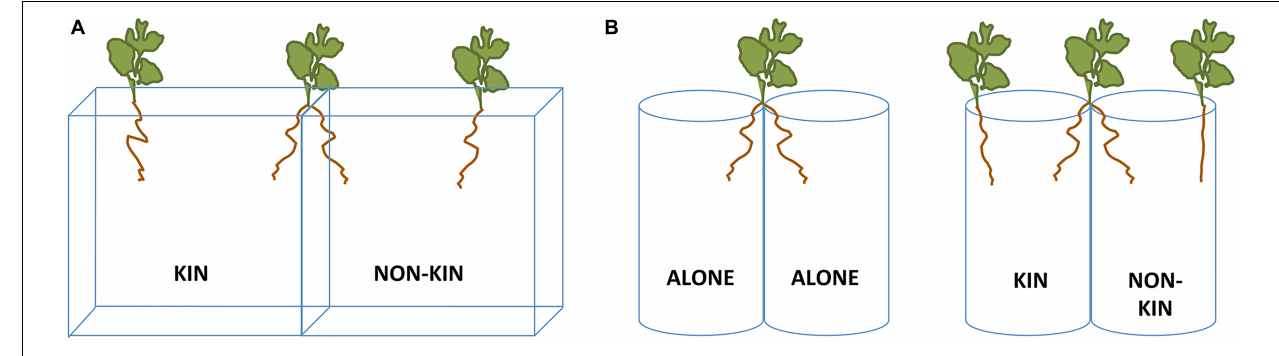
models. Log-transformed data were used for width of the deepest root to ensure models residuals were normally distributed. Post- hoc pairwise tests were used where significant differences between treatments were found using the package emmeans (Lenth,